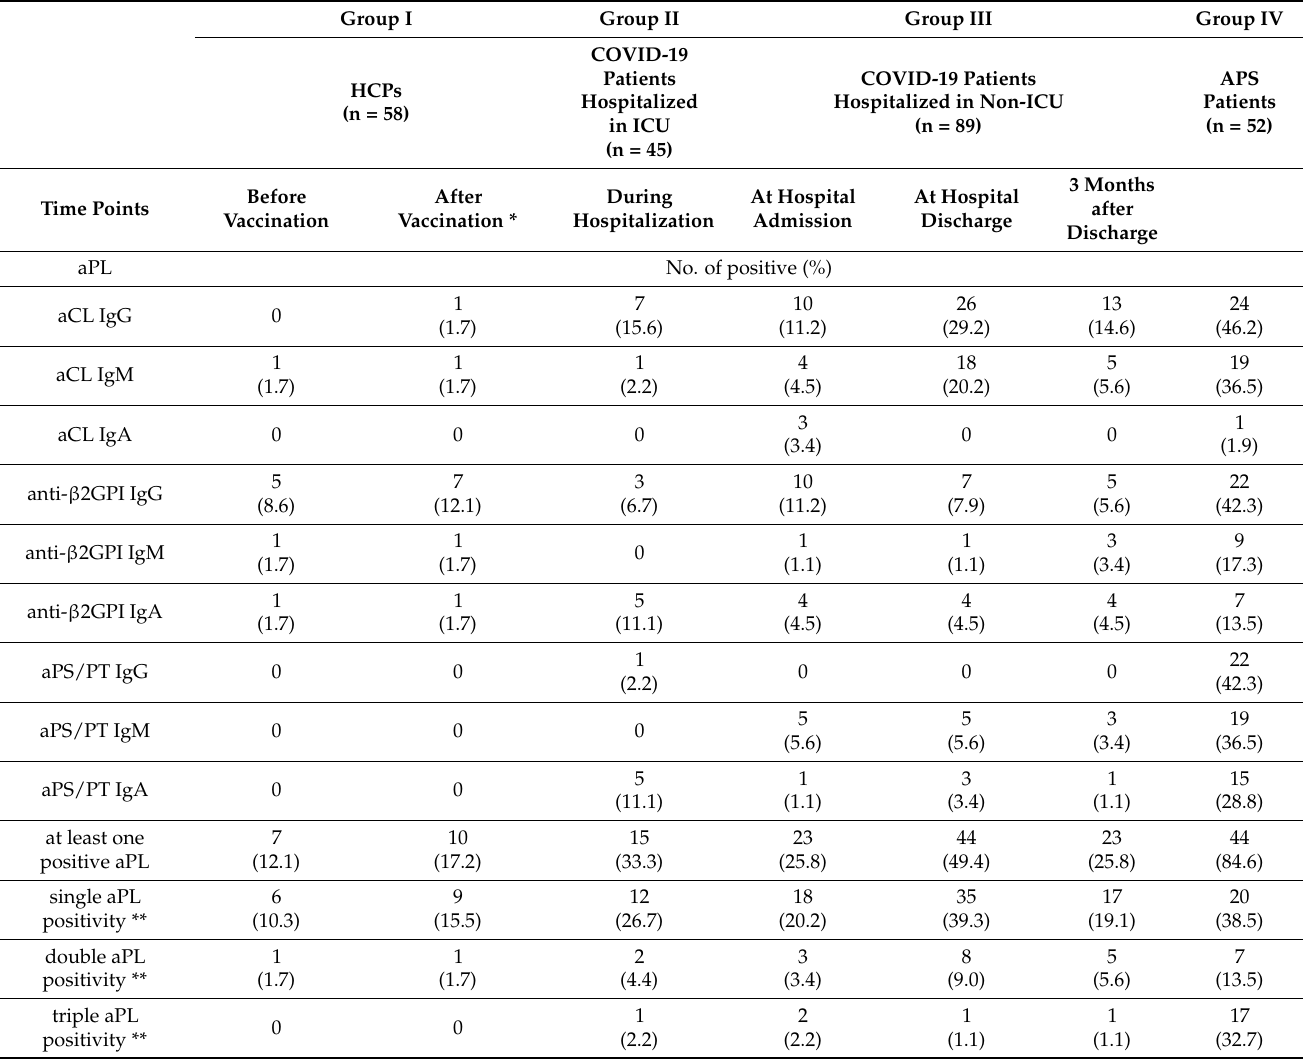
Table 2. The prevalence of positive aPL in sera samples from HCPs before and after vaccination (group I), COVID-19 patients hospitalized in the ICU (group II), COVID-19 patients hospitalized in the non-ICU (at three time points: admission, hospital discharge, 3-month follow-up after hospital discharge) (group III), and APS patients (group IV). Group I Group II Group III Group IV COVID-19 Patients COVID-19 Patients APS HCPs Hospitalized Hospitalized in Non-ICU Patients (n = 58) in ICU (n = 89) (n = 52) (n = 45) 3 Months At Hospital At Hospital after Admission Discharge